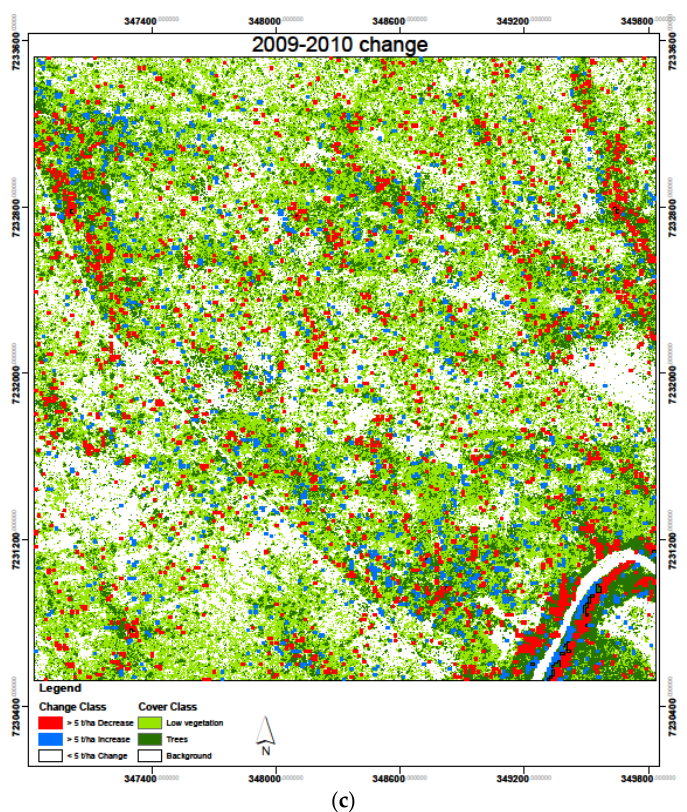
Figure 14. Biomass change results over the study period 2007–2010, with six change combinations with ( a ) 2007–2008; ( b ) 2008–2009; and ( c ) 2009–2010. Table 5. Relative change in AGB in Skukuza between 2007 and 2010.